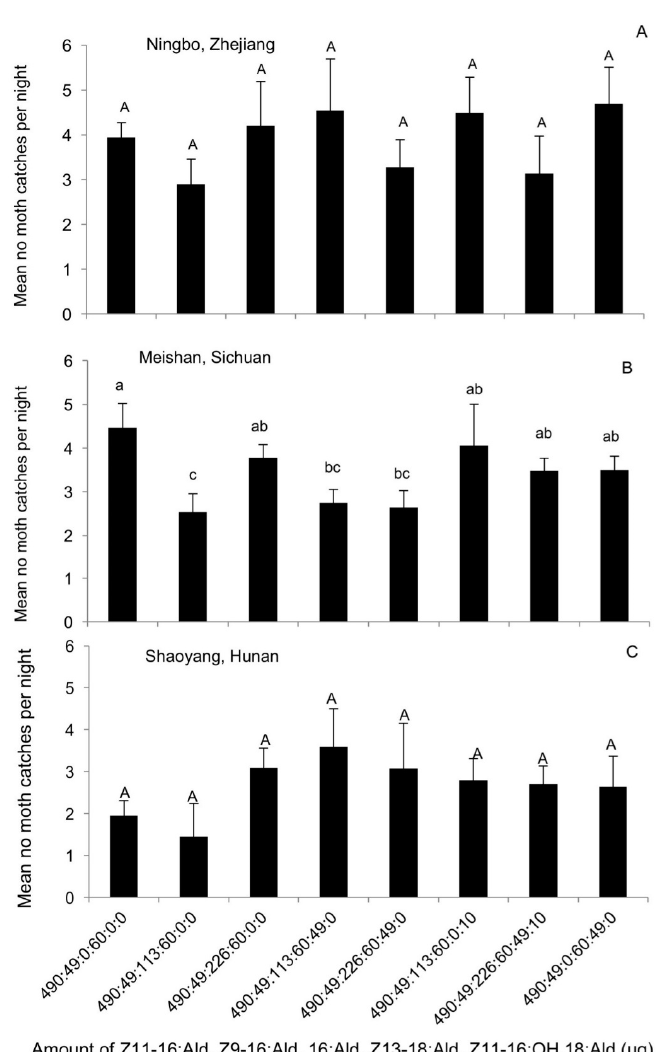
Figure 5. The average number of male Chilo suppressalis moths caught per trap per night in the rice fields in ( A ) Ningbo, Zhejiang (28 June–30 July 2012); ( B ) Meishan, Sichuan (30 June–25 July 2012); ( C ) Shaoyang, Hunan (12 August–30 August 2012), by lures made up of mixed blends of the pheromone components Z11-16:Ald, Z9-16:Ald, Z13-18:Ald, 16:Ald, Z11-16:OH, 18:Ald, in the ratios indicated along the x axis. Each treatment was replicated six times. Treatment bars represent the standard errors; bars with different letters above them are significantly different from each other in the number of male moths captured ( p < 0.05).